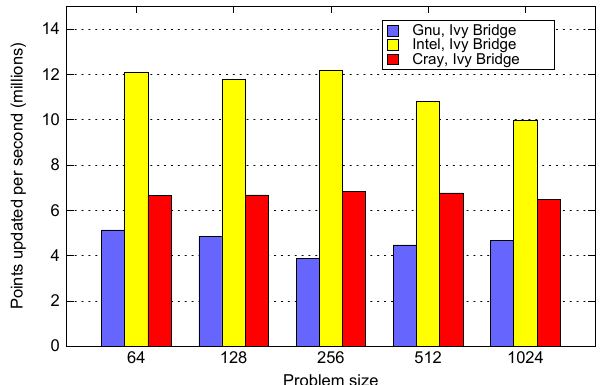
Figure 2. Summary of the performance of the original version of the NEMOLite2D code on an Intel Ivy Bridge CPU for the range of compilers under consideration.